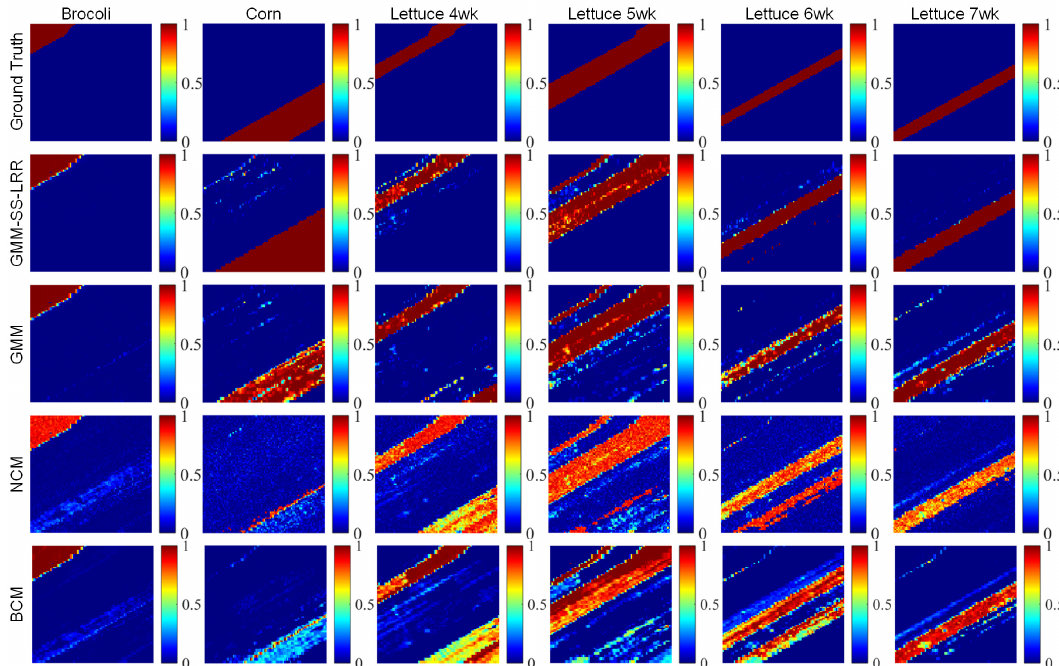
Figure 11. Abundance maps for the Salinas-A dataset. From top to bottom: Ground truth, GMM-SS-LRR, GMM, NCM, and BCM. The corresponding endmembers from left to right are: broccoli, corn, lettuce 4wk, lettuce 5wk, lettuce 6wk, lettuce 7wk.